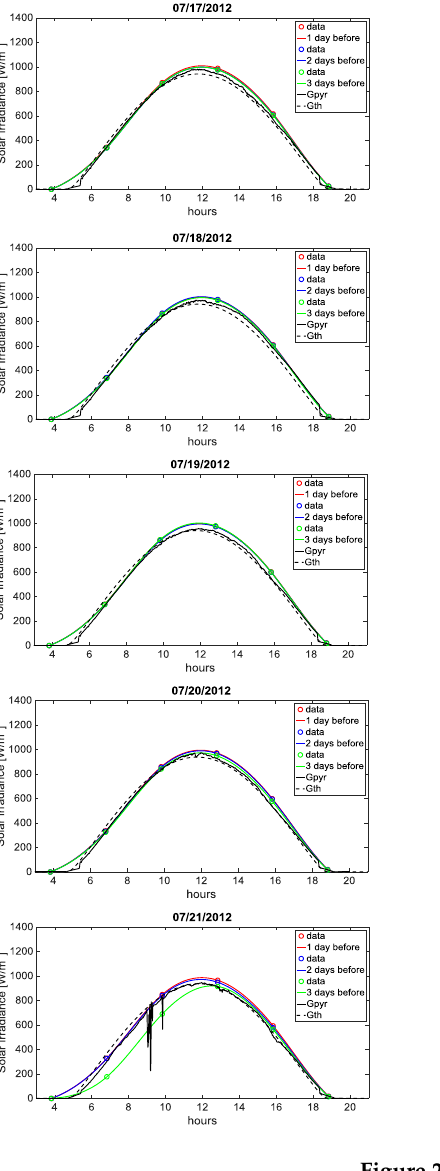
Figure 2. Cont. Figure 2.